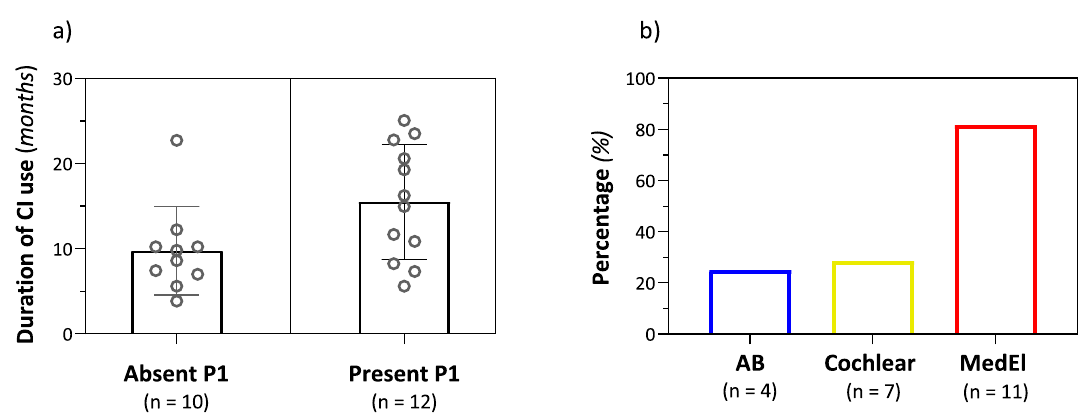
Figure 1. P1 prevalence for /m/ demonstrated for the background variables of ( a ) duration of CI use (months)—showing individual data points and means (± SD), indicating a significant difference between absent and present P1 (mean of 9.77 vs. 15.95 months, respectively) ( p = 0.04). ( b ) CI manufacturer—showing P1 prevalence for each manufacturer, indicating a significantly higher prevalence in children implanted with the Medel device (81.8%) compared to Cochlear (28.5%) and Advanced Bionics (AB) (25%) ( p =